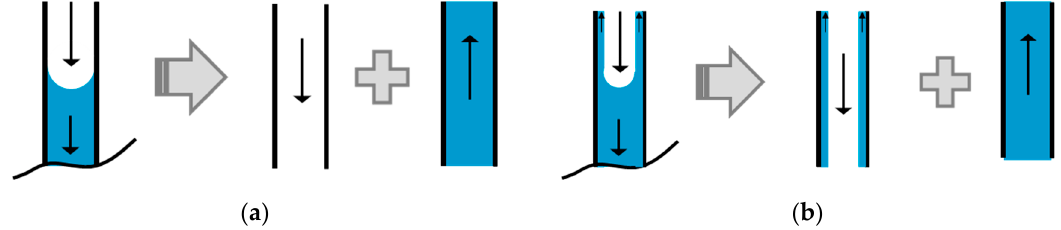
Figure 15. ( a ) Plug flow invasion of the gas phase (invasion regime #6) completely separating the gas transporting from the liquid transporting pore space. ( b ) Annular invasion of the gas phase according to [58] (invasion regime #5), leading to annularly wetted pore space transporting gas towards the water supply channel in the center and liquid films transporting water towards the catalyst layer, as well as fully saturated pores and throats.